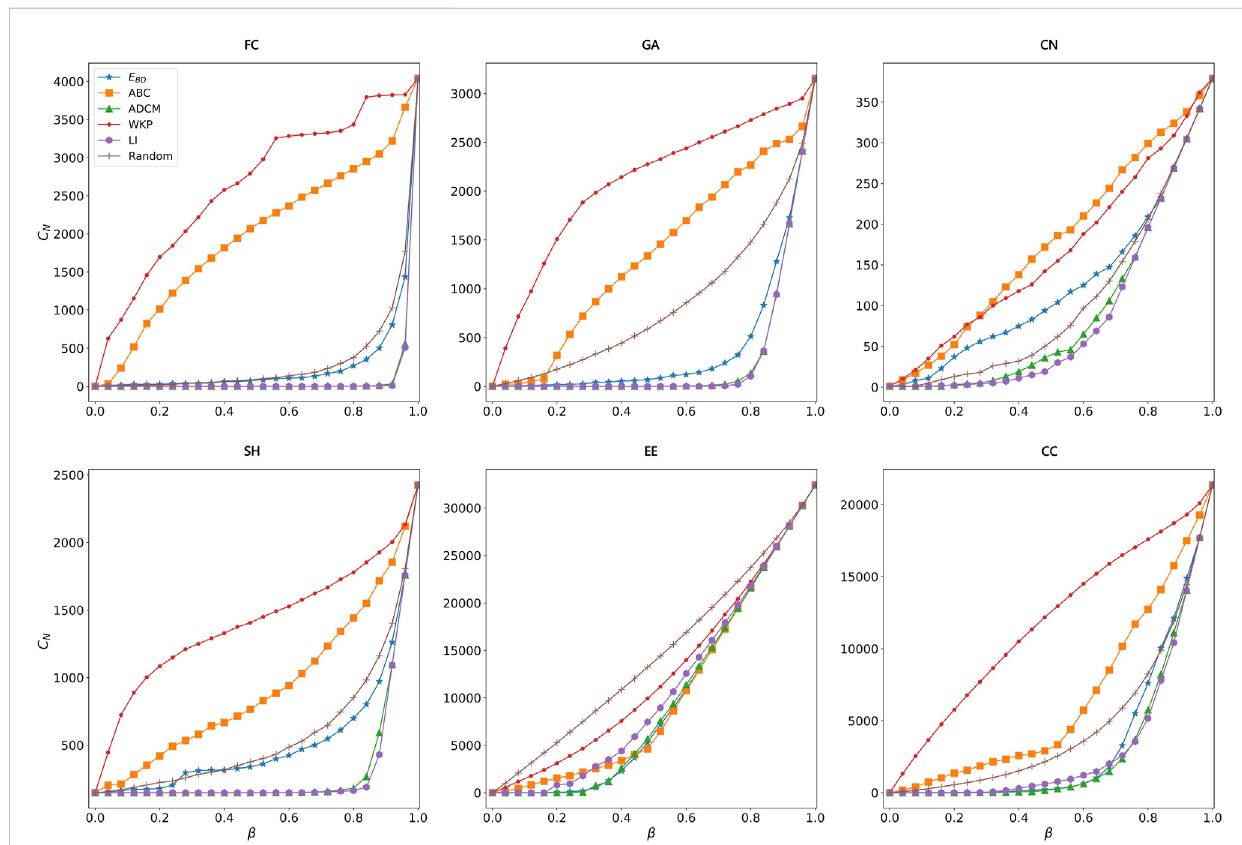
FIGURE 7 Performance comparison of our method E BD ( α =0.5) and the others in preserving connectivity. Here, six networks (i.e., FC, GA, CN, SH, EE and CC) are considered. The vertical axis represents the number of connected components ( C N ) in current network, and the horizontal axis represents β which means the proportion edges being removed in the network.